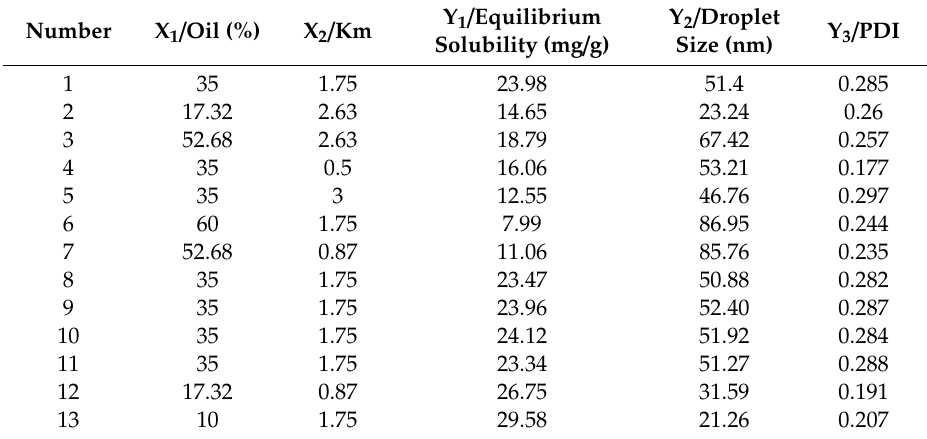
Table 4. The results of central composite design. Km: weight ratio of surfactant to co-surfactant; PDI: polydispersity